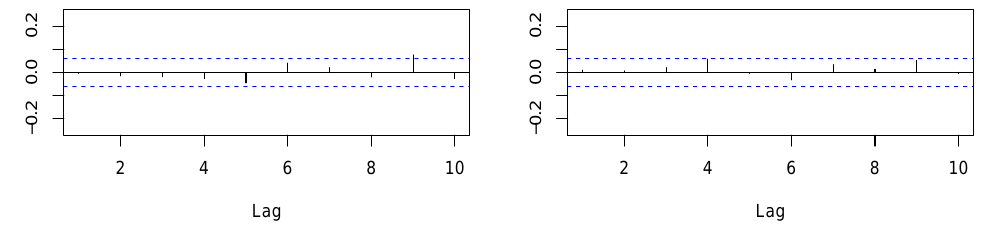
Figure 4. (cid:98) L t , in-sample autocorrelations of AR(5) residuals ( left ) and their squares ( right ).